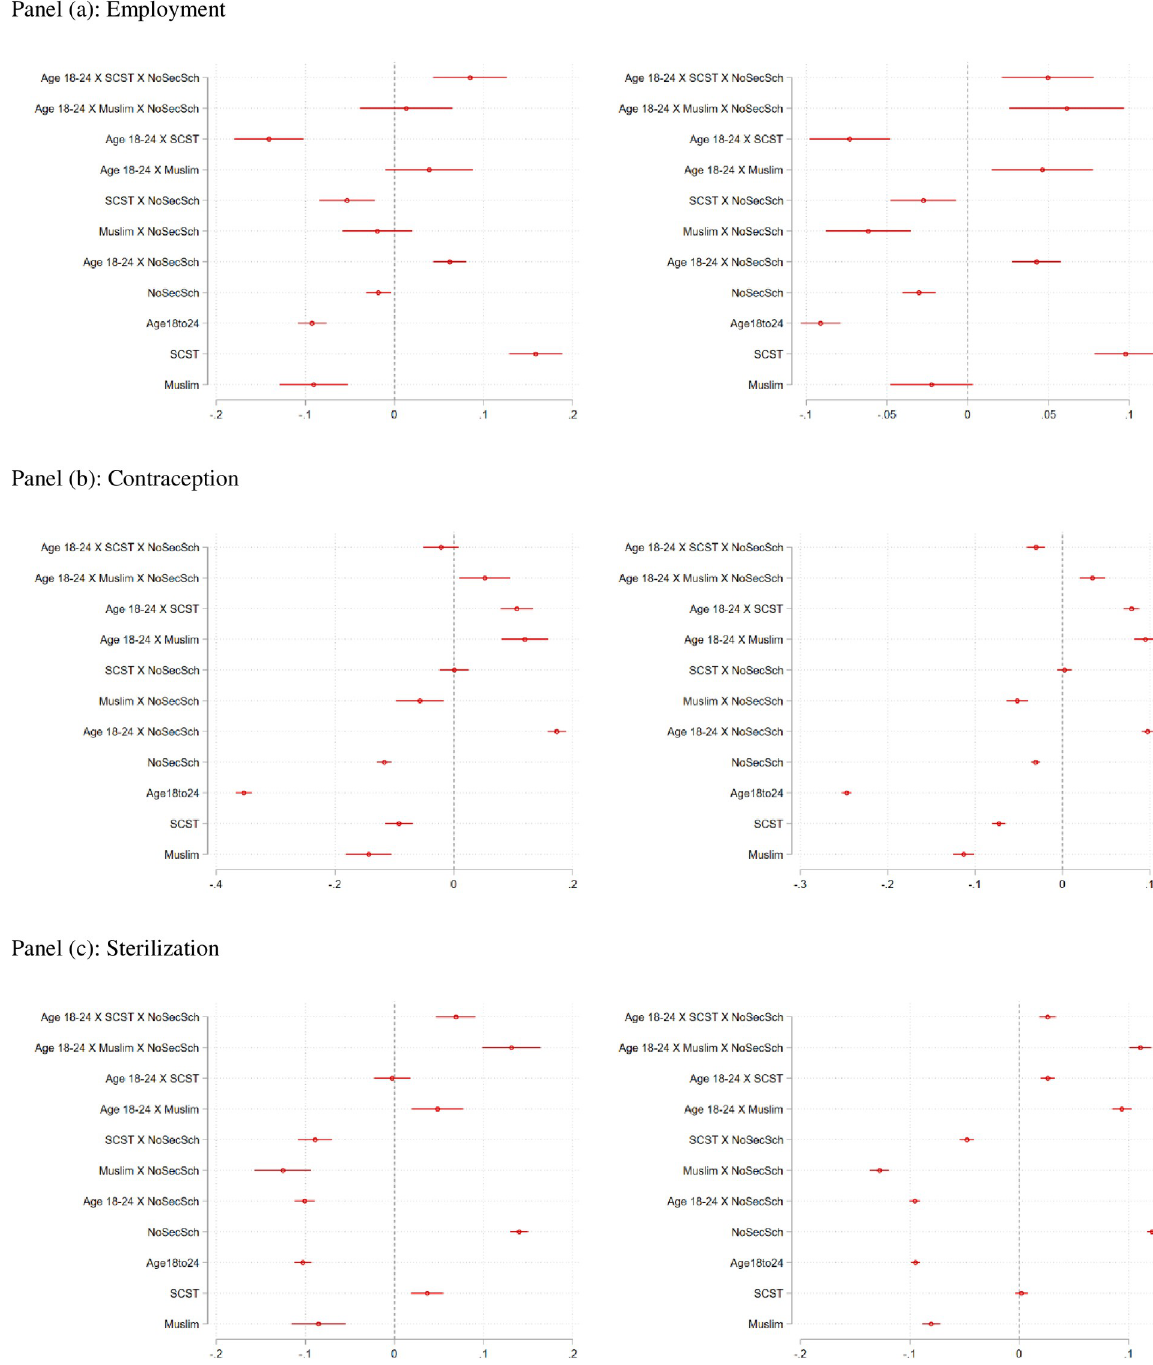
Fig 8. Coefficients, with confidence intervals, for regressions of the prevalence of female sterilization (as measured by a dummy variable) on age intervals as well as a set of control variables that include age at marriage, schooling (as measured by completion of secondary school), dummies for religious groups, dummies for caste groups and state-level fixed-effects. The excluded group in all regressions is the group above than the age of 40.